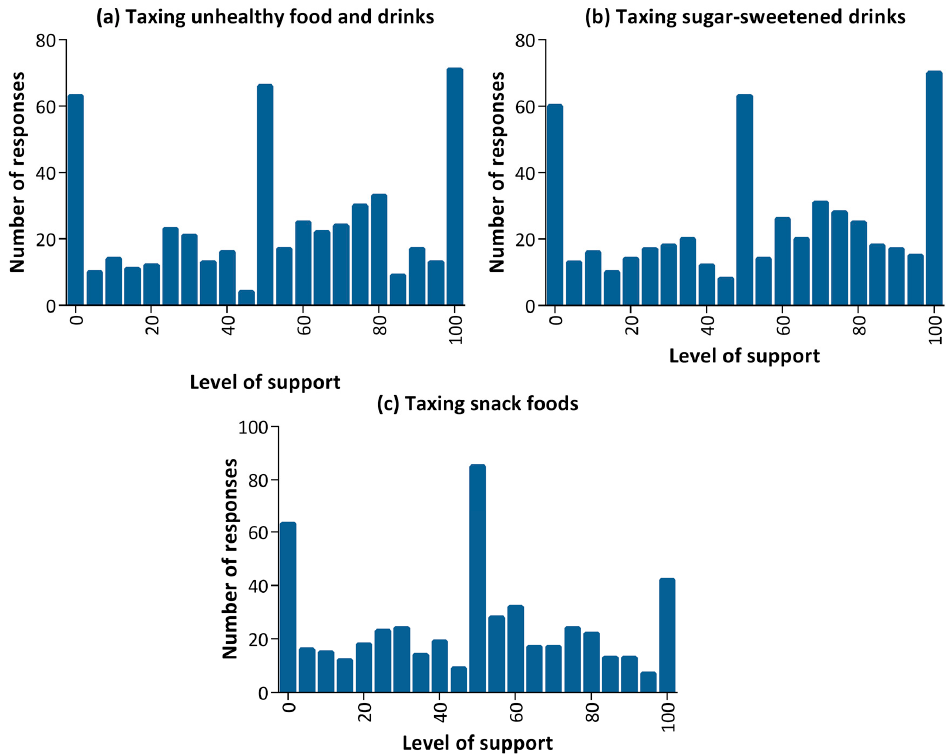
Figure 1. Support for the different taxation strategies: ( a ) taxing unhealthy food and drinks; ( b ) taxing sugar-sweetened drinks; ( c ) taxing snack foods.